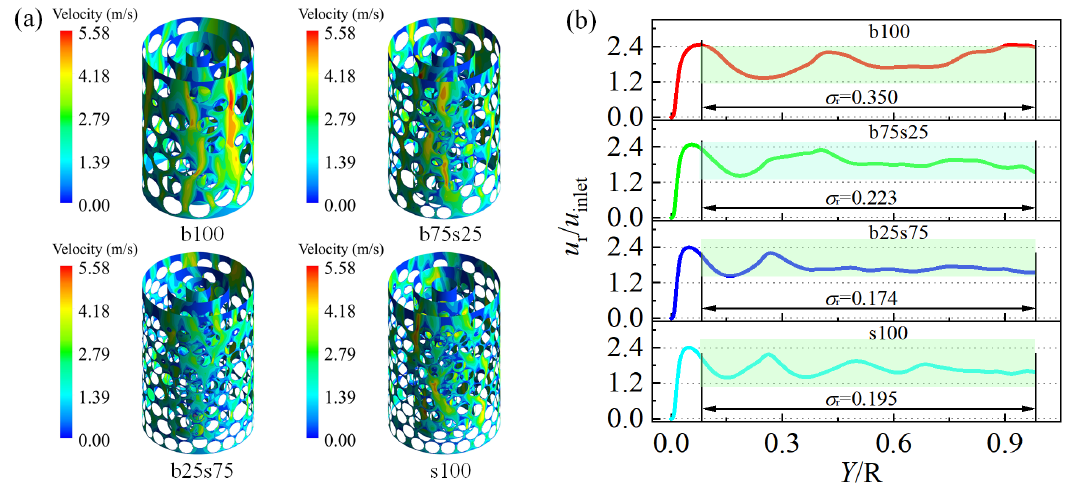
Figure 14. ( a ) Construction of radial velocity distribution; ( b ) relative velocity distributions along the radial direction in different packed beds.